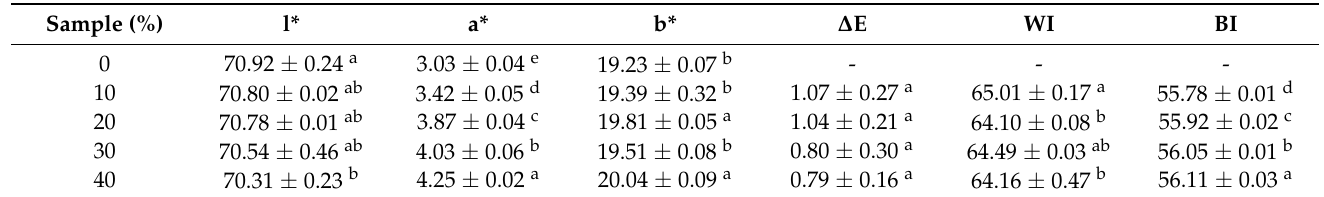
Table 1. Effect of different additions of white kidney bean flour on the colour of the noodles.